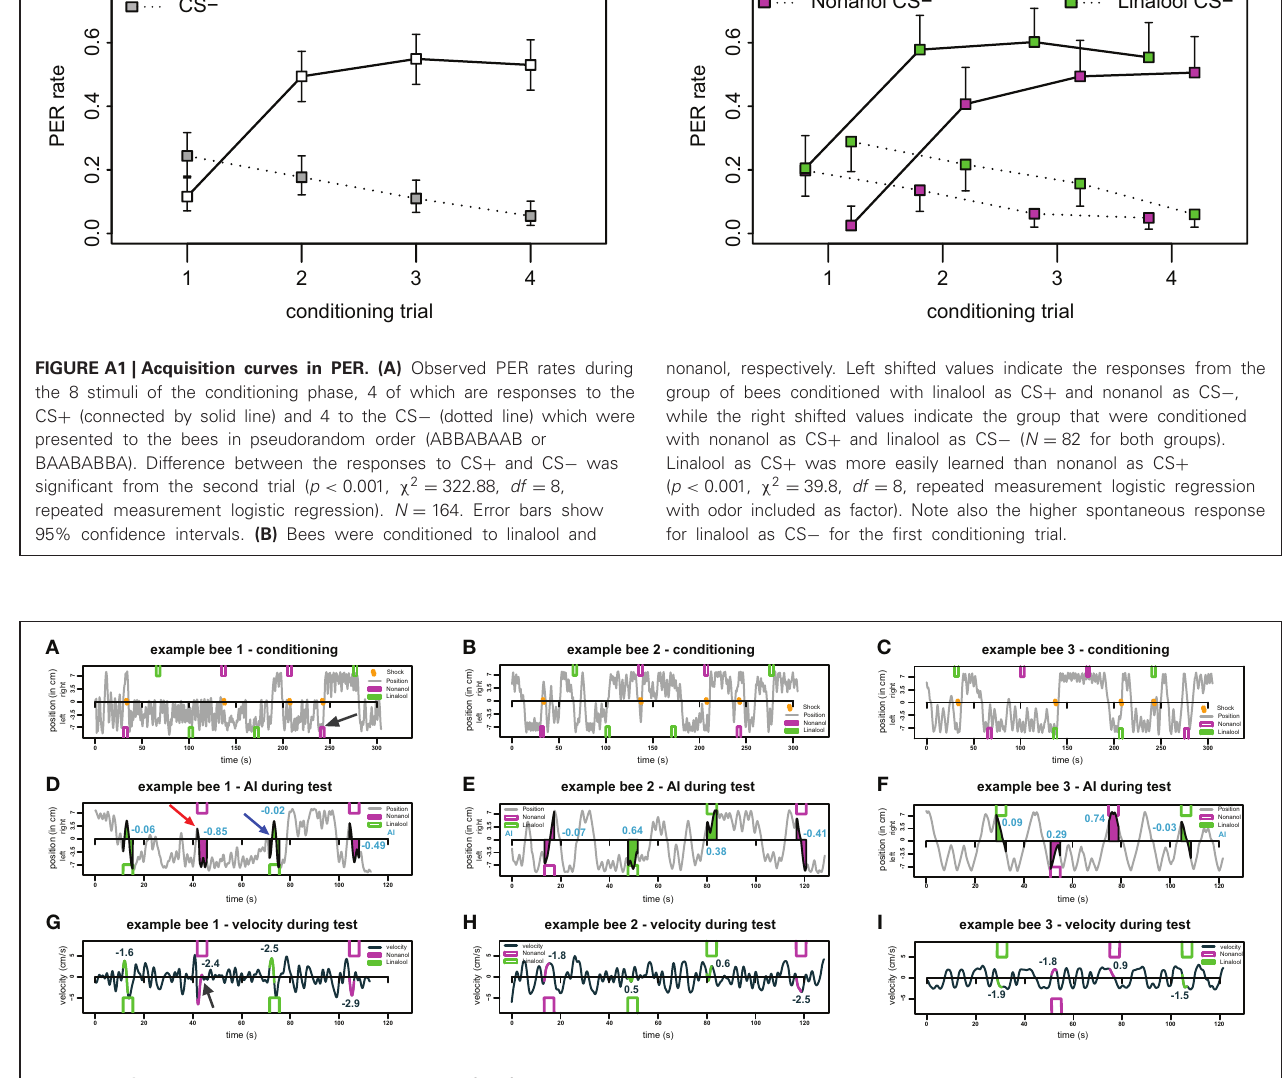
blue numbers show the respective AI of each response. Crossing away from odor injection side without crossing back during stimulation period was counted as an escape. An example of an escape is indicated by the red arrow in (D) , the blue arrow indicates an example of a non-escape—the bee returns to the side it originated from. (G–I) Sea green line indicates velocity of same bees as in A–F , respectively, during the test. Colored parts of the line indicate the parts from which average velocity of each trial was calculated. The numbers indicate the respective velocity for each stimulus. Black arrow in (G) indicates an increase in velocity during odor presentation (escape), followed by local